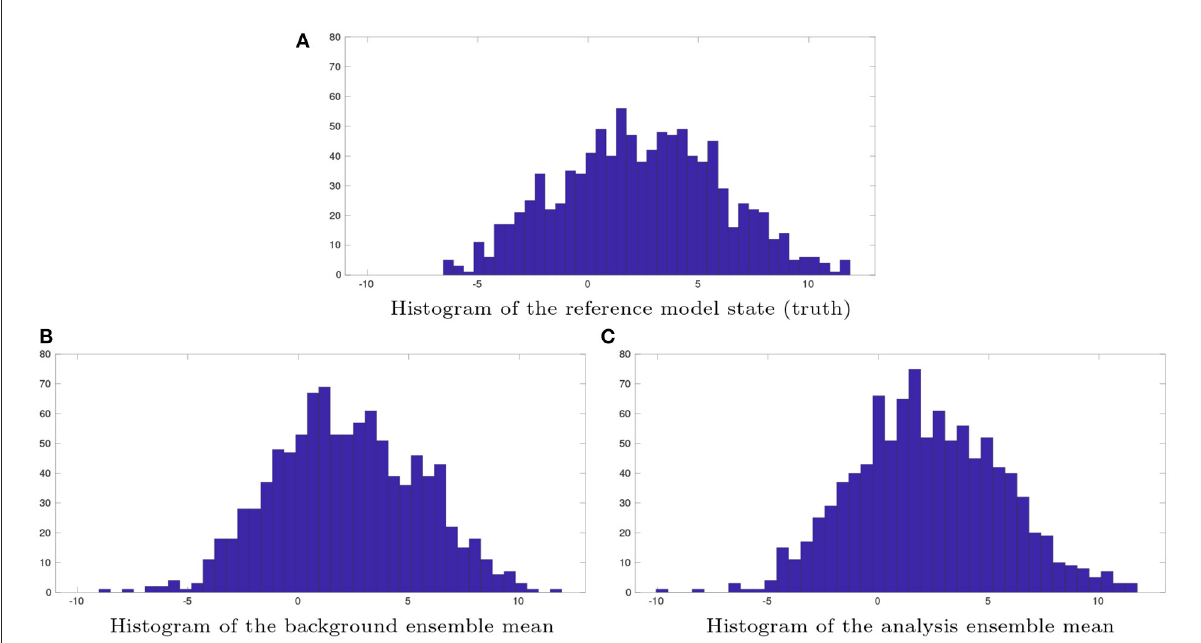
FIGURE8 Histograms of (A) the reference model state (truth), (B) the background ensemble mean, and (C) the analysis ensemble mean at one of the assimilation cycles in the 1,000-dimensional L96 model. Both the reference model state and the background ensemble do not change over the IES iteration process, whereas the analysis ensemble is obtained by inserting the ensemble of estimated hyper-parameters at the last iteration step into the reference algorithm (Equation 31), of the MIF